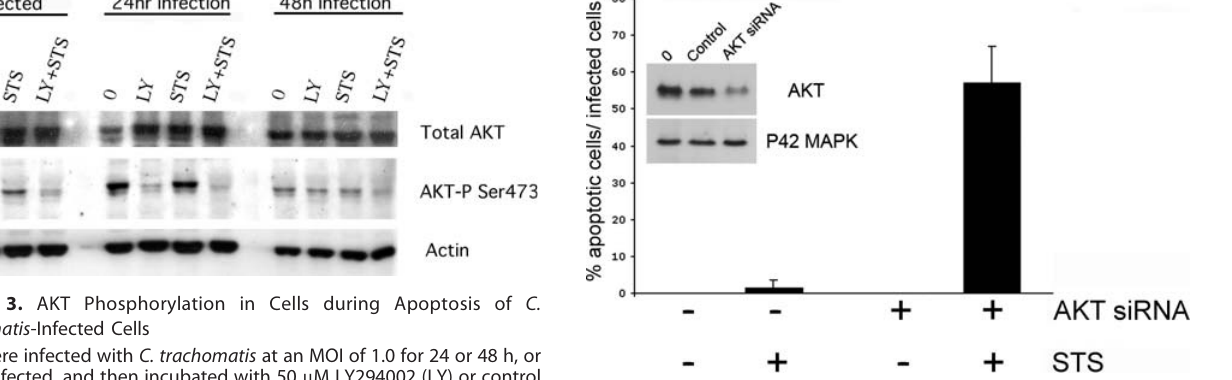
Figure 4. Effect of Inhibition of AKT Expression on Apoptosis of C. trachomatis -Infected Cells Cells were transfected with AKT siRNA ( þ ) or control reagents ( (cid:1) ) for 8 h, infected with C. trachomatis at an MOI of 1.0 for 32 h, and then incubated with 2 l M STS or control buffer overnight. The efficiency of transfection with AKT siRNA in epithelial cells was monitored by co-transfecting with fluorescein-labeled irrelevant siRNA, which showed that approximately 80% of cells were transfected during the experiments (unpublished data). DNA was revealed with Hoechst and Chlamydia with anti- Chlamydia antibody. The extent of nuclear condensation was measured only in cells that contained Chlamydia vacuoles. No nuclear condensa- tion was observed in infected cells that expressed normal levels of AKT, but STS led to nuclear condensation in infected cells that had been transfected with AKT siRNA. One experiment of two representative experiments performed on separate days is shown. Inset: Inhibition of AKT expression in epithelial cells by RNA interference. Cells were transfected with siRNA for AKT or controls. After 48 h, the cells were harvested and AKT protein levels were measured by Western immunoblotting. The control reagents did not affect AKT expression, and AKT siRNA had no effect on the expression of another protein, the P42 MAP kinase. DOI: